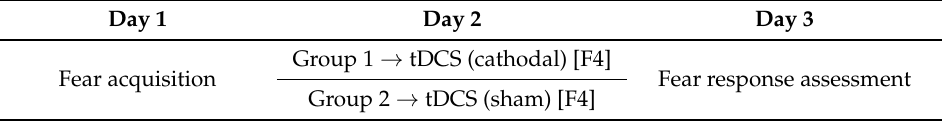
Table 1. Overview and timeline of the experiment. tDCS: transcranial direct current